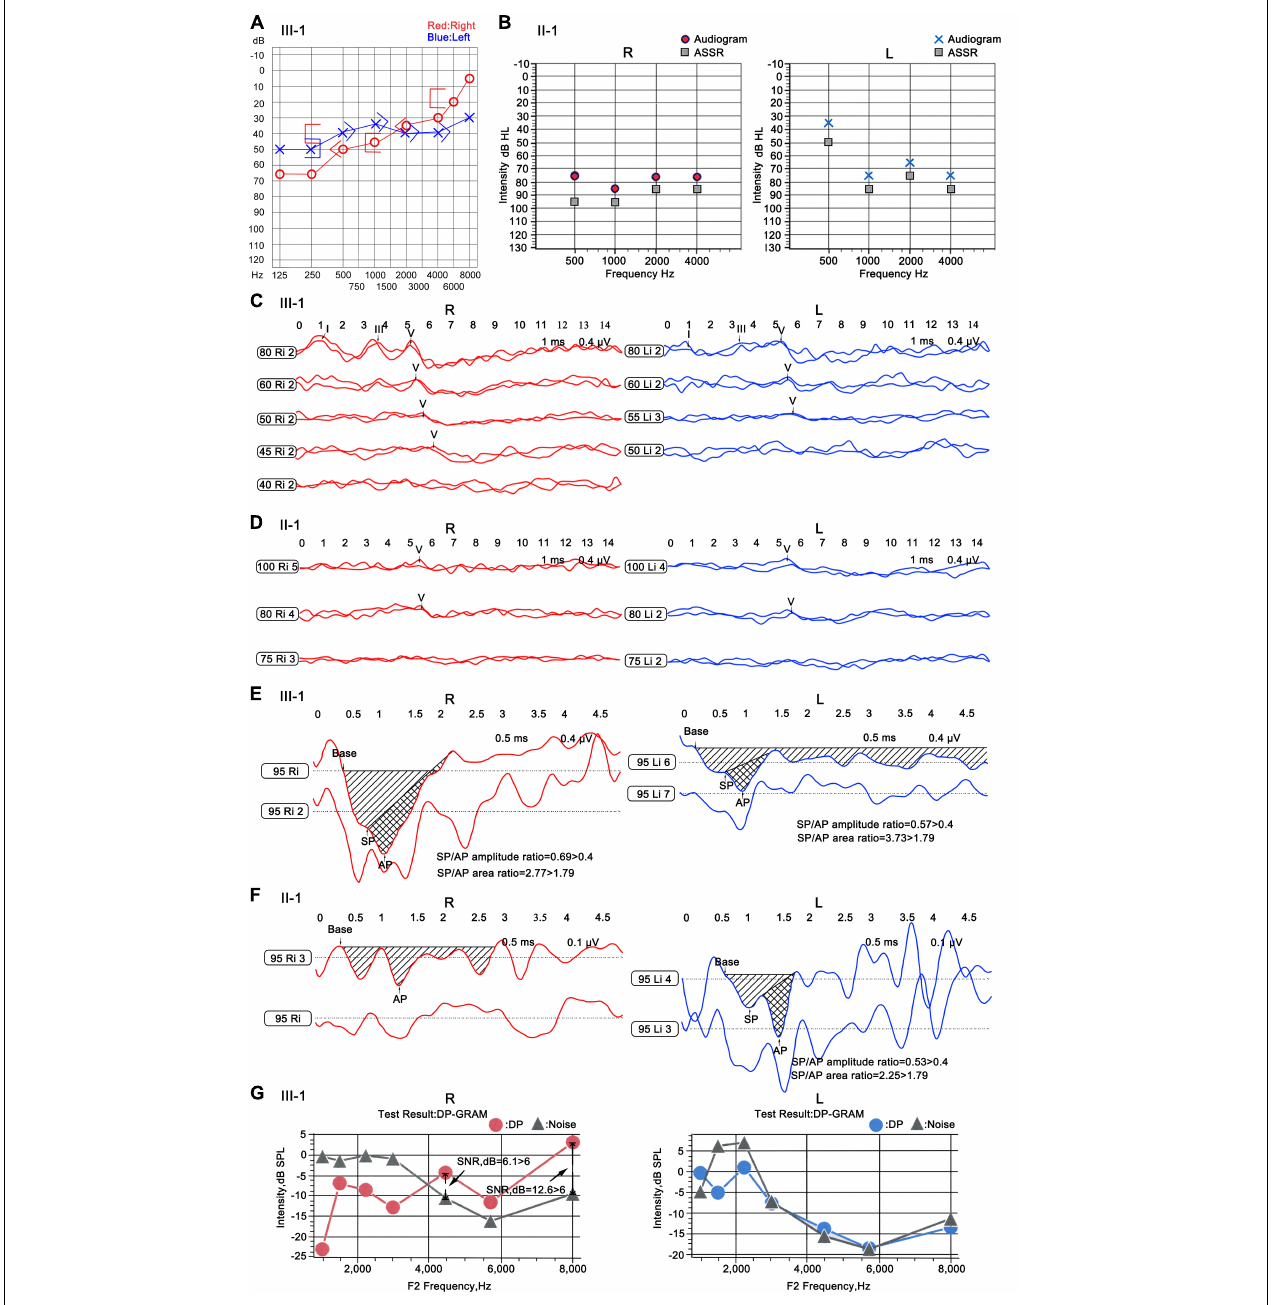
FIGURE 3 | Audiology examination for the patients of the ND family. (A) Pure tone audiometry of III-1. “ ” and “ ” indicated that contralateral ear was masked; “ < ”and “ > ” indicated bone conduction thresholds; “ ” and “ ” indicated air conduction thresholds. (B) ASSR of II-1. Base, baseline; “ ”: the thresholds of ASSR; “ ” and “ ”: the calibrated response threshold of ASSR (Audiogram). (C,D) ABR of III-1 and II-1. (E,F) ECochG of III-1 and II-1. Base, baseline; SP, summating potential; AP, compound action potential. (G) DPOAE of III-1. DP, DPOAE amplitude; Noise, background noise amplitude; SNR, signal noise ratio; SNR > 6 dB indicates that the test is pass. R, right ear; L, left